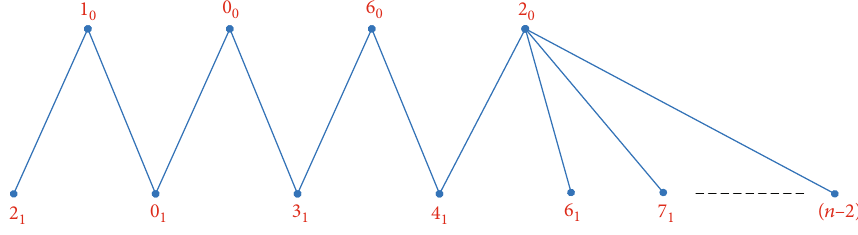
Figure 20: An orthogonal labeling for C